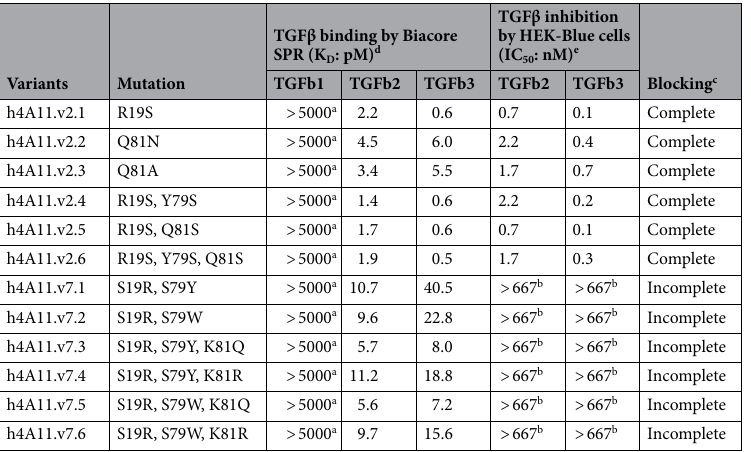
Table 3. Functional characterization of humanized 4A11 version 2 and version 7 heavy chain framework mutation variants. a The binding was not observed at the highest TGFβ1 concentration (5 nM); therefore, the reported KD are lower limits. b The maximun inhibition did not achieve over 90% at the highest antibody concentration (667 nM); therefore, the reported IC50 are lower limits. c The complete blocking or incomplete blocking was defined by TGFβ2 and TGFβ3 inhibition greater than 90% or less than 70%, respectively, at the highest antibody concentration. d The affinity constant (K D ) for each variant is calculated using a global fitting model and reported as a single value for the whole data set with an average fitting standard error of 10%. e The half-maximal inhibitory concentration (IC 50 ) for each variant from quadruplicate experiments is calculated using nonlinear regression with a four-parameter variable slope curve fit and reported as a single value with an average fitting standard error of 10%.